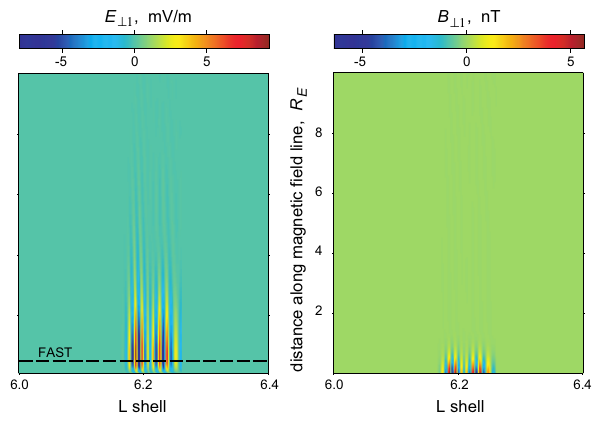
Fig. 3. Snapshot of the transverse electric field, E 1 ⊥ , and the trans- verse magnetic field, B 1 ⊥ , inside the half of the computational do- main at the time t = 200 s.